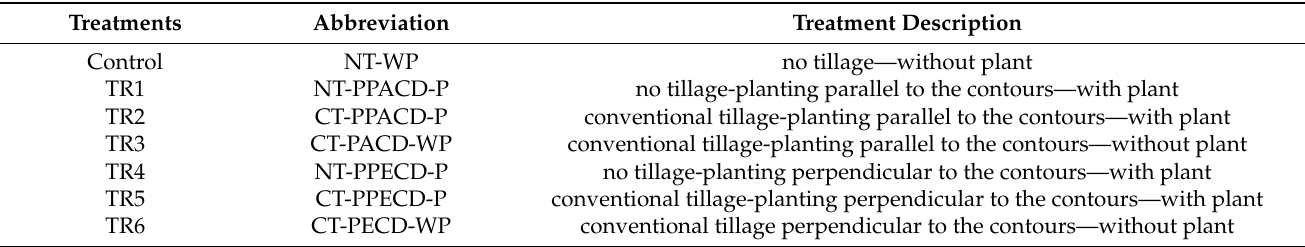
Table 13. Abbreviations and description of the